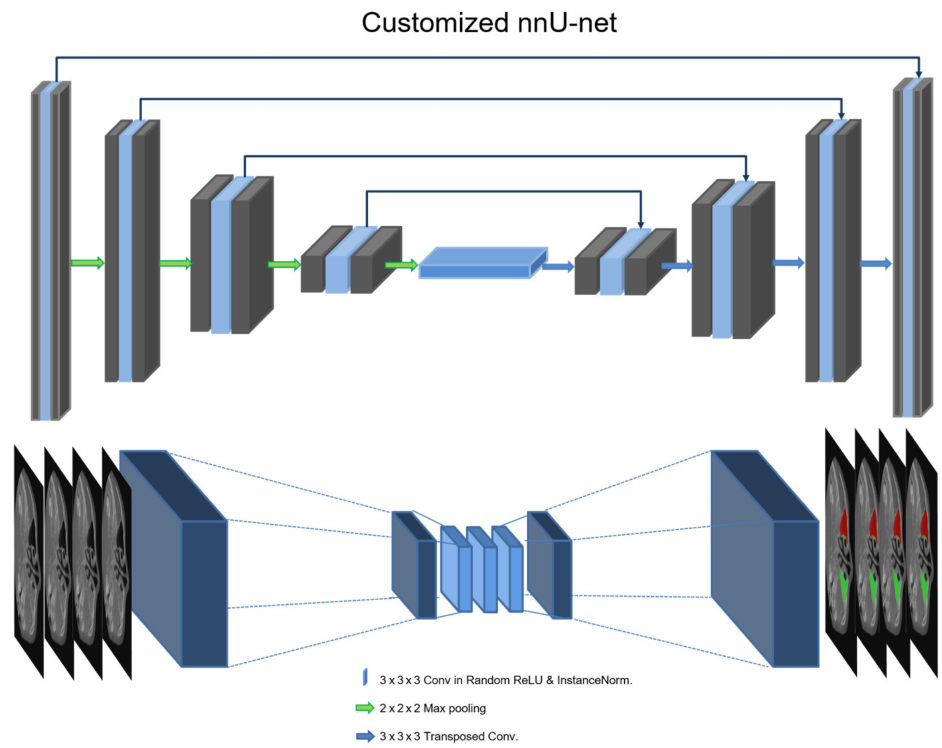
Figure 1. Deep learning architecture of the customized 3D U-Net in the